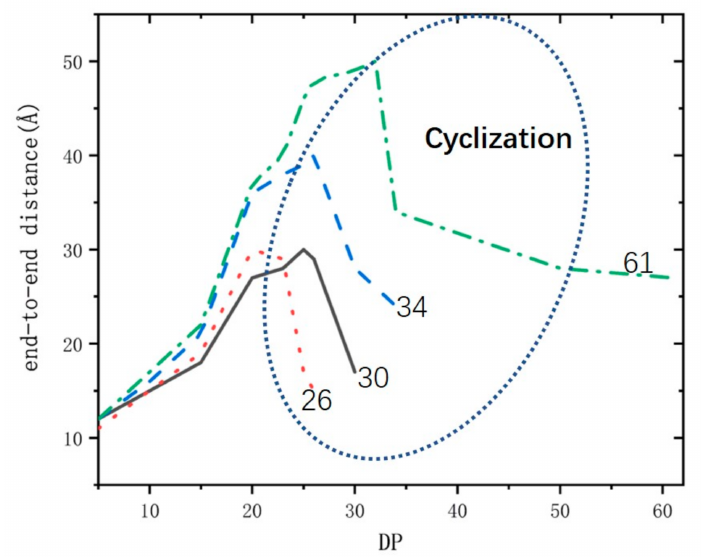
Figure 7. The end-to-end distance evolution of the 1-pentene–maleic anhydride (1PM) polymers with different polydispersity index (DP). Its values are showed at the end of the